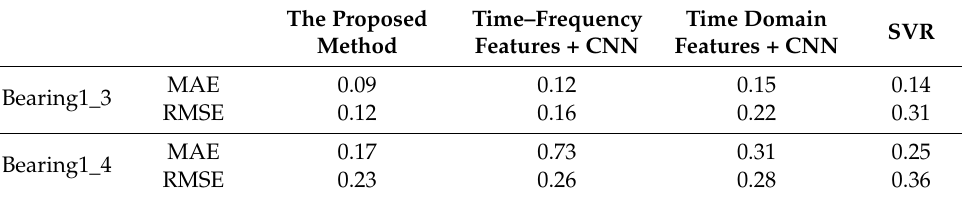
Table 1. Numerical prognostic performance comparisons of different methods. The Proposed